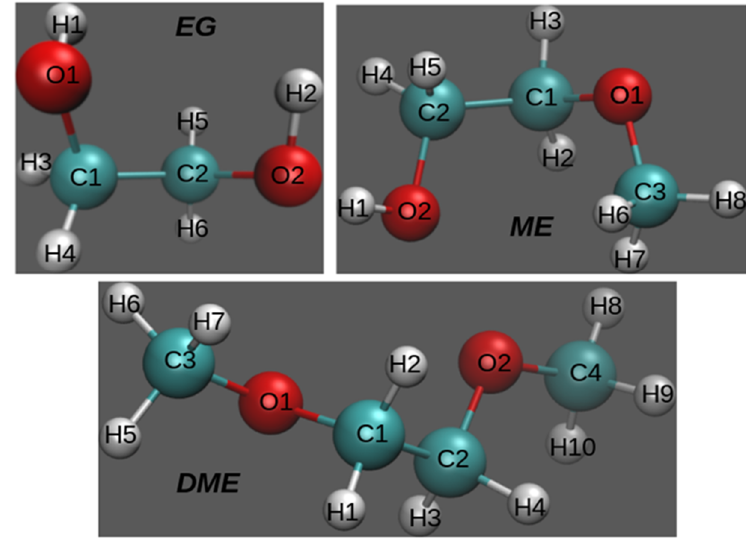
Figure 4. Sketch of the molecules with atom numbering .